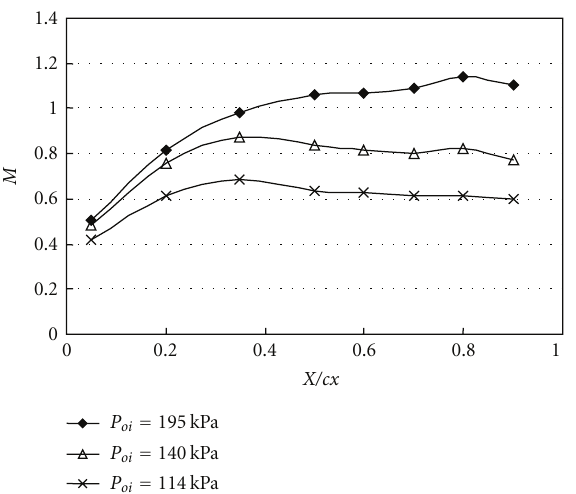
Figure 2: Airfoil Mach number distributions employed for the symmetric airfoil investigations [5, 8].